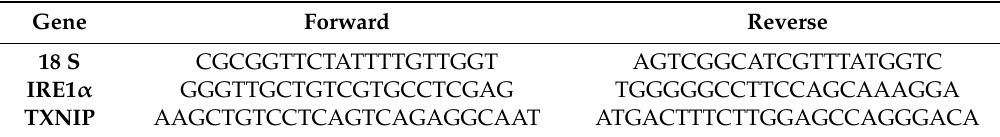
Table 1. The sequence of the PCR primers used in the mRNA quantification experiments.